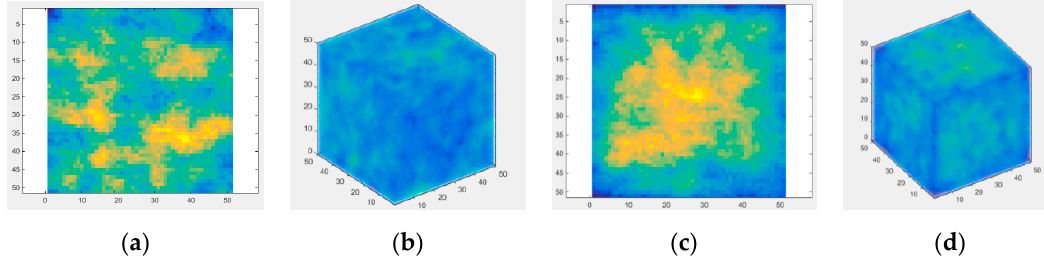
( c ) Figure 6. ( a ) The schematic of the unit vector. ( b ) The schematic of the normal plane and 𝑎⃗ , 𝑏 (cid:4652) (cid:4652)⃗ . ( c ) Carbon paper structure obtained by this stochastic reconstruction method. Anisotropy of the fiber in the thickness direction (through-plane) can be reflected by fiber pitch, which is defined as the angle the fiber makes with the plane of the material (stochastic modeling of polymer electrolyte membrane fuel cell gas diffusion layers, Part 1: Physical characterization). The fiber pitch 𝛼 and the polar angle 𝜃 are related to each other, and the conversion formulas are shown as follows: (cid:3422)𝛼 = 𝜋 2 − 𝜃, 0 (cid:3409) 𝜃 (cid:3409) 𝜋 2 𝛼 = 𝜃 − 𝜋 2 , 𝜋 2 (cid:3407) 𝜃 (cid:3409) 𝜋